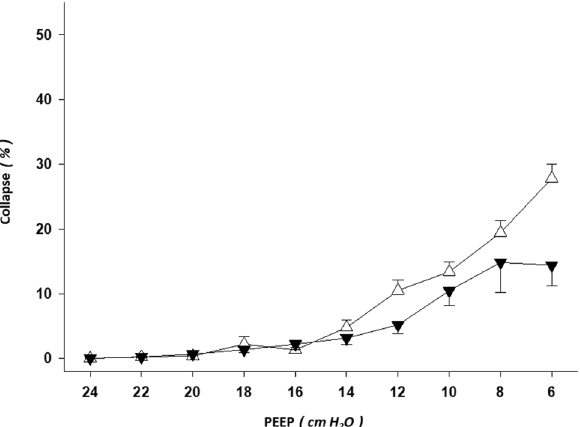
Figure 2. Lung collapse by electrical impedance tomography in supine vs. prone body position. Line graphs of the electrical impedance tomography (EIT)-based estimations of lung collapse from forty-two decremental positive end-expiratory pressure (PEEP) titrations—supine vs. prone body position—are shown (mean ± SEM). Triangle up (white): supine body position. Triangle down (black): prone body position. X axis: decremental